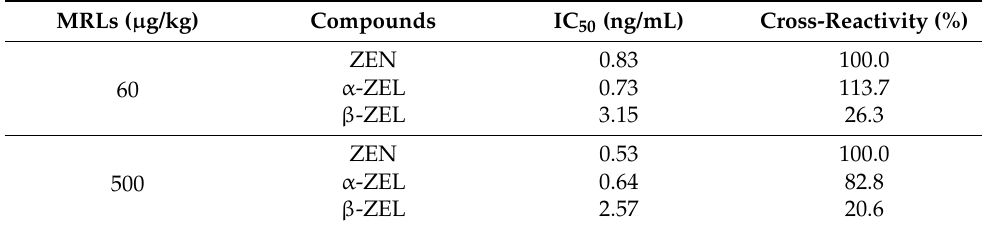
Table 1. IC 50 values and Cross-reactivity of the ZEN and its analogues determined by the developed of ic-ELISA.